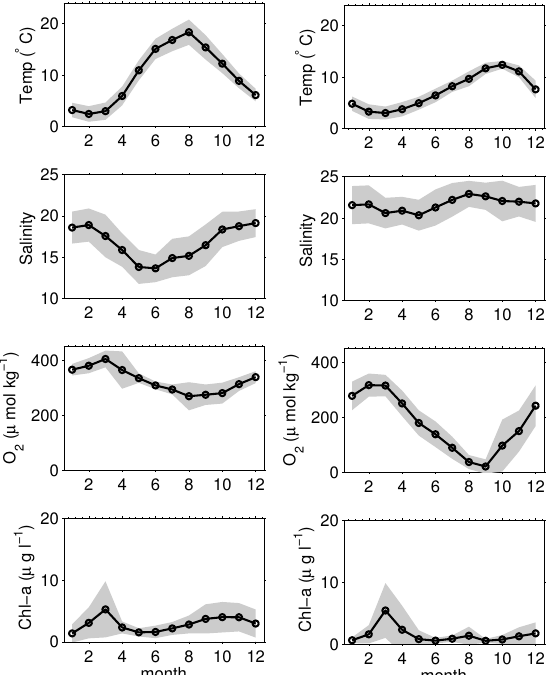
Figure 5. Long-term mean (1982 to 2012) seasonal cycle of BE parameters for all data above 2m (left) and below 24m (right). Grey shading indicates the standard deviation.